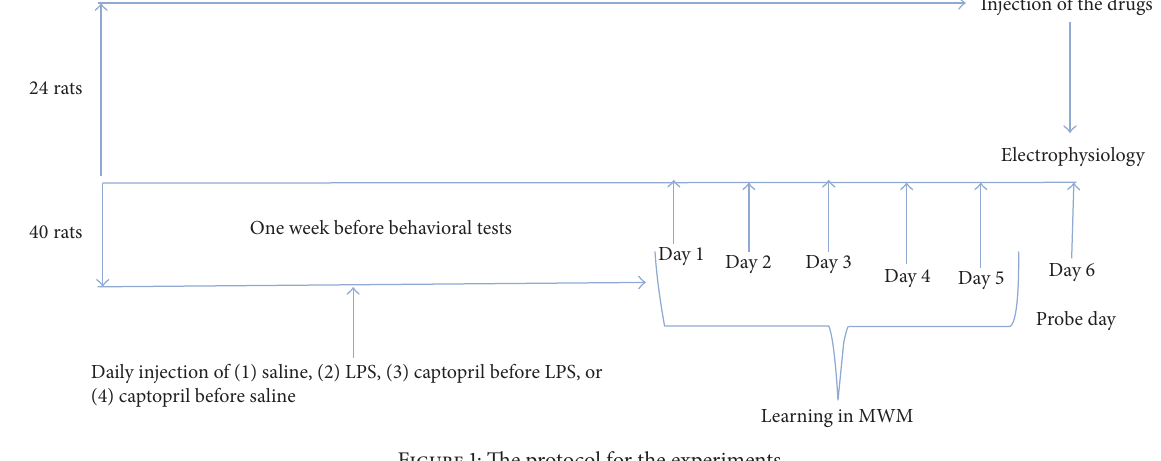
Figure 1: The protocol for the experiments.